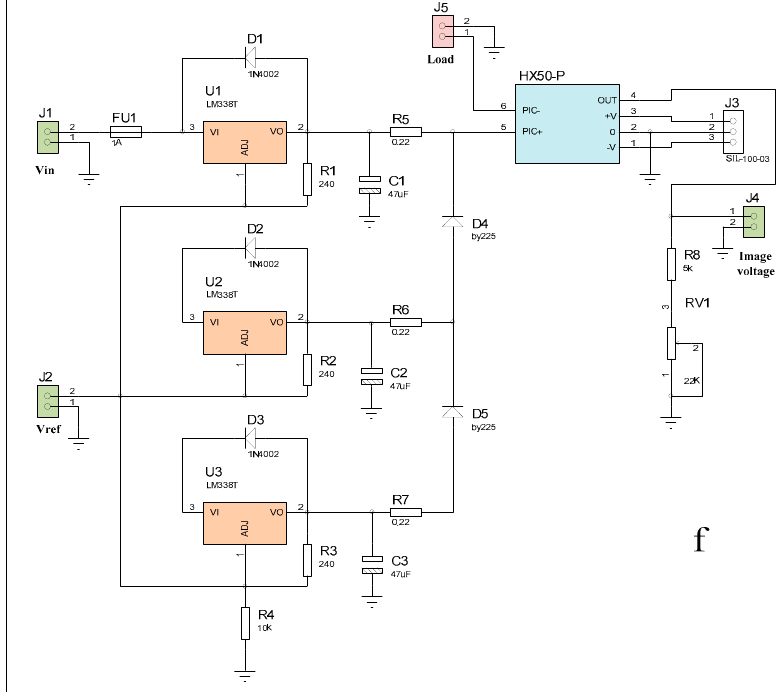
Figure 10. Parallel-placed LM338 regulators in the PV emulator power stage.